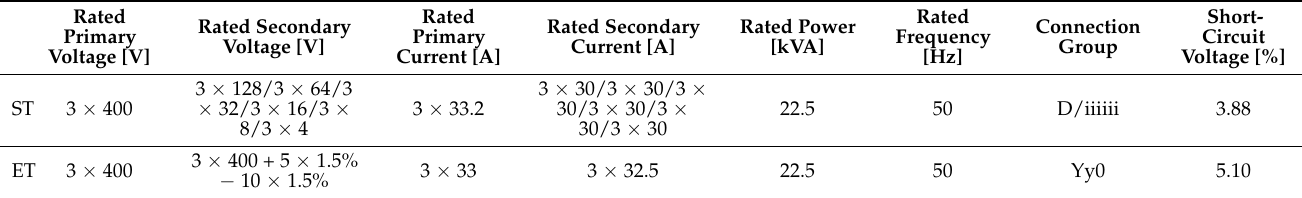
Figure 10. The Simulink power system equivalent in the SPST case. Table 2. Laboratory transformer parameters used to build